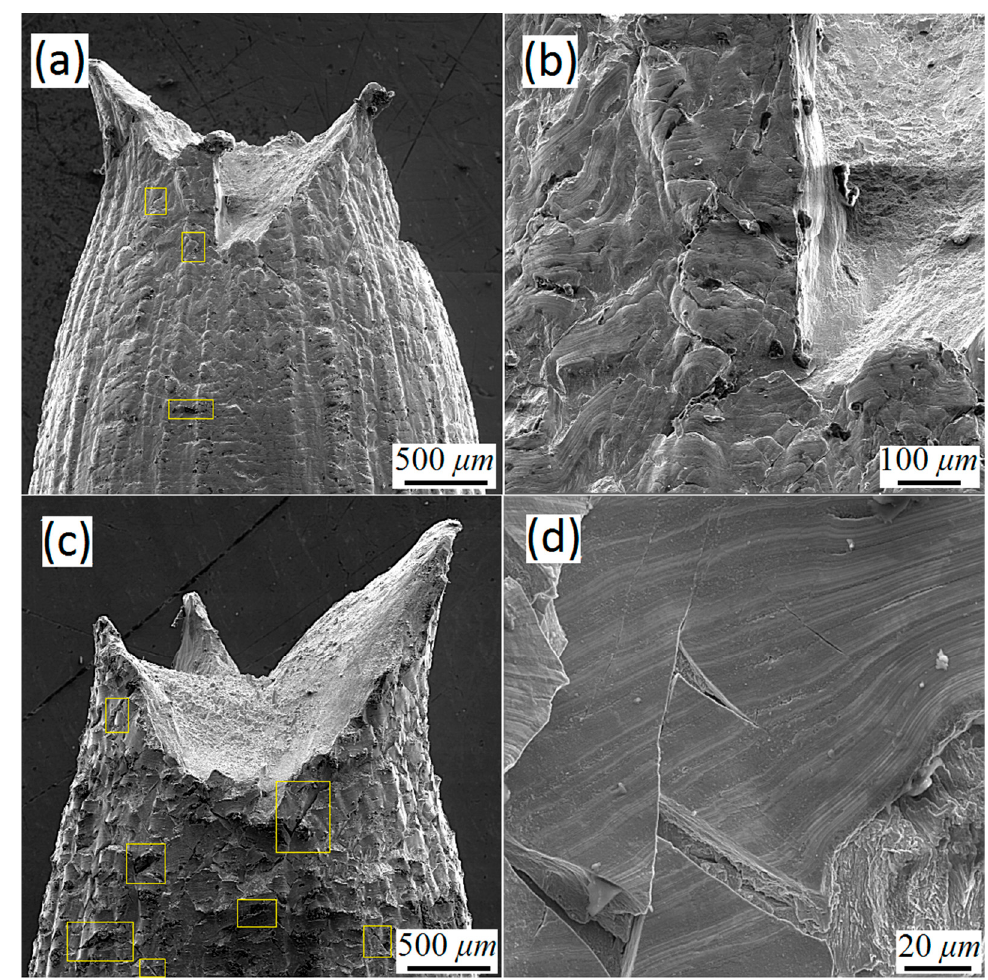
Figure 8. SEM images of the fractured surfaces from longitudinal direction: ( a , b ) UC-1.2 and ( c , d ) C-4.8, with the same magnification to highlight the number of surface cracks that were detected on the sample. ( b , d ) are higher magnification of ( a , c ), respectively. The yellow rectangles refer to the surface cracks.